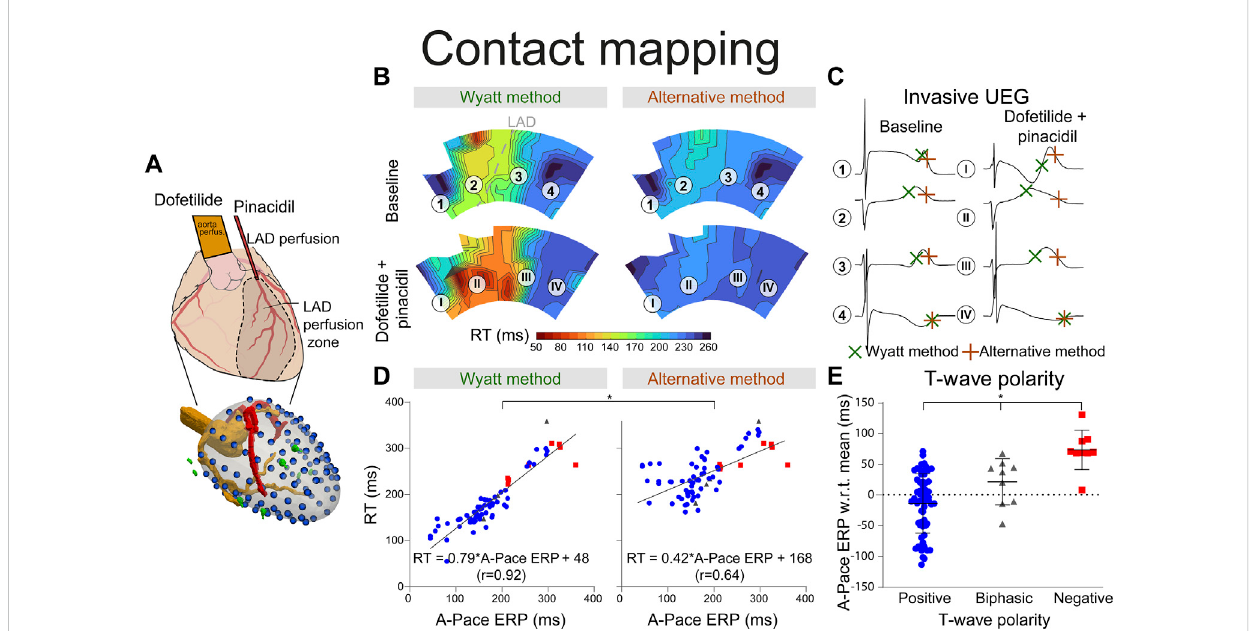
FIGURE 3 RT determined by the Wyatt and alternative method through contact mapping. (A) experimental setup; the LAD was infused with pinacidil which shortensrepolarization whilethenon-LAD regionwasinfused withdofetilide, which prolongsrepolarization.Unipolar electrogramsweremeasuredwith an epicardial sock. (B) RT as determined by the Wyatt versus alternative method before and during drug infusion. (C) electrograms corresponding to different locations in (B) . (D) linear regression when comparing A-pace ERP (see text) to RT determined by both the Wyatt and alternative method. Positive T-waves are shown in blue, biphasic T-waves in gray, and negative T-waves in red. (E) A-pace ERP of positive, biphasic and negative UEG T-waves,withrespecttothemeanA-paceERPofthesameexperiment.Figures (D,E)